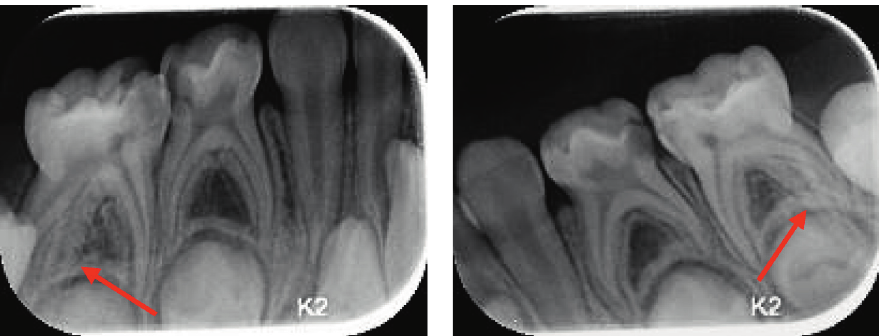
Figure 2: Bilateral occurrence of extra roots in second primary molars of the mandible.